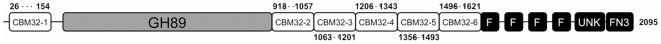
Schematic representation of the modular structure of CpGH89.CBM32 denotes family 32 carbohydrate-binding modules, GH89 represents the family 89 catalytic module, F denotes the predicted FIVAR (Found In Various Architectural Regions) modules and FN3 refers to a fibronectin type III domain. Modular boundaries used in this study are given above and below the schematic.